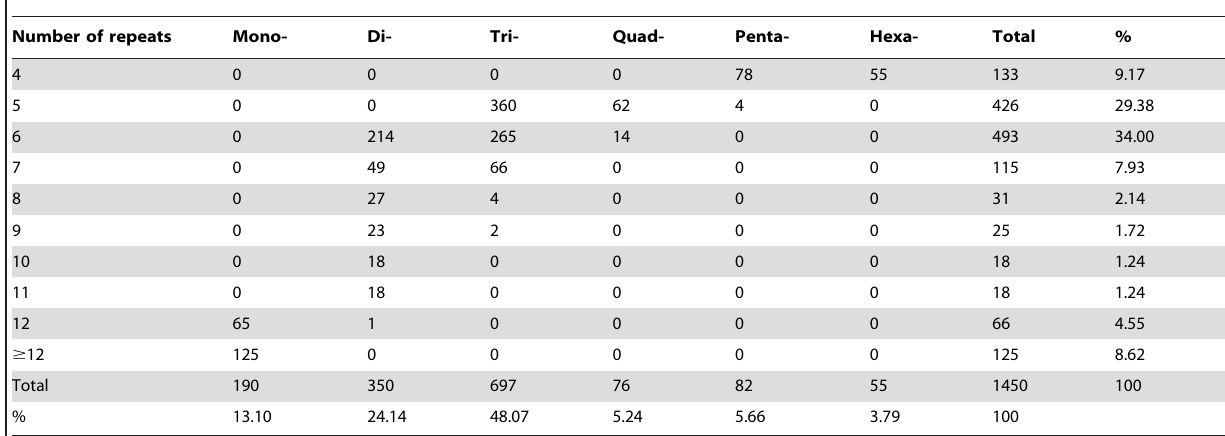
Table 5. Distribution of SSRs based on the number of repeat